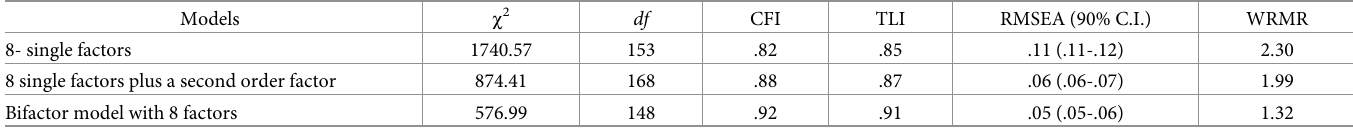
Table 1. Goodness-of-fit indices of the dimensional models tested.